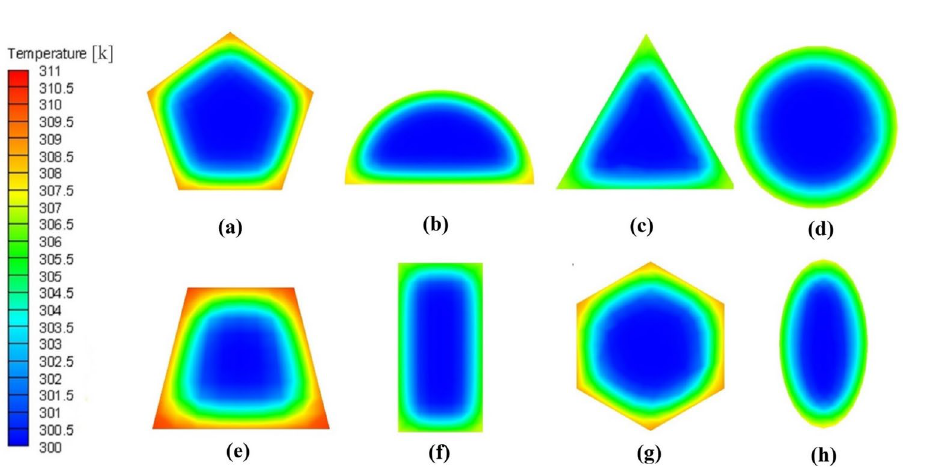
Figure 6. Temperature distribution contours for eight of the selected distinguished